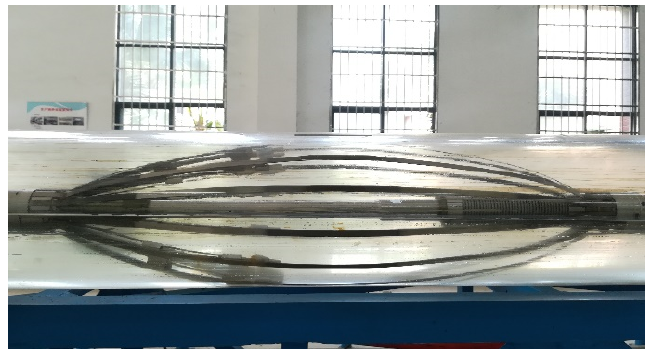
Figure 3. Structure diagram of Capacitance Array Tool (CAT) instrument.